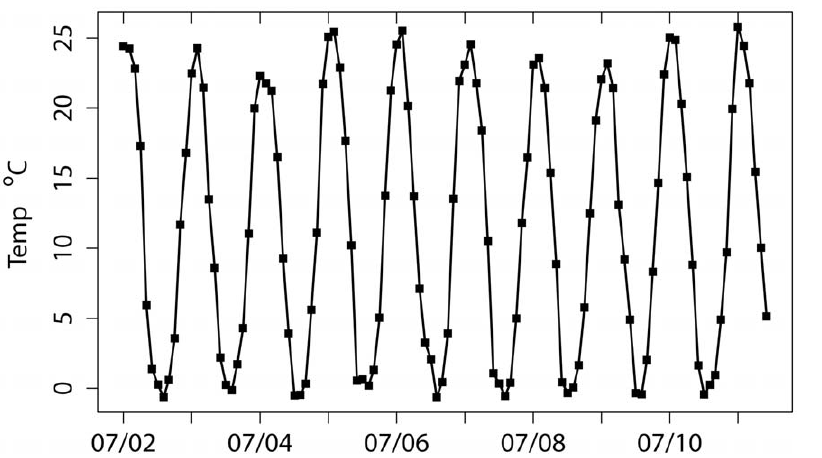
Figure 6. Monthly mean water temperature in western Lake Erie from 2002–2011. Tick marks indicate July of each year.